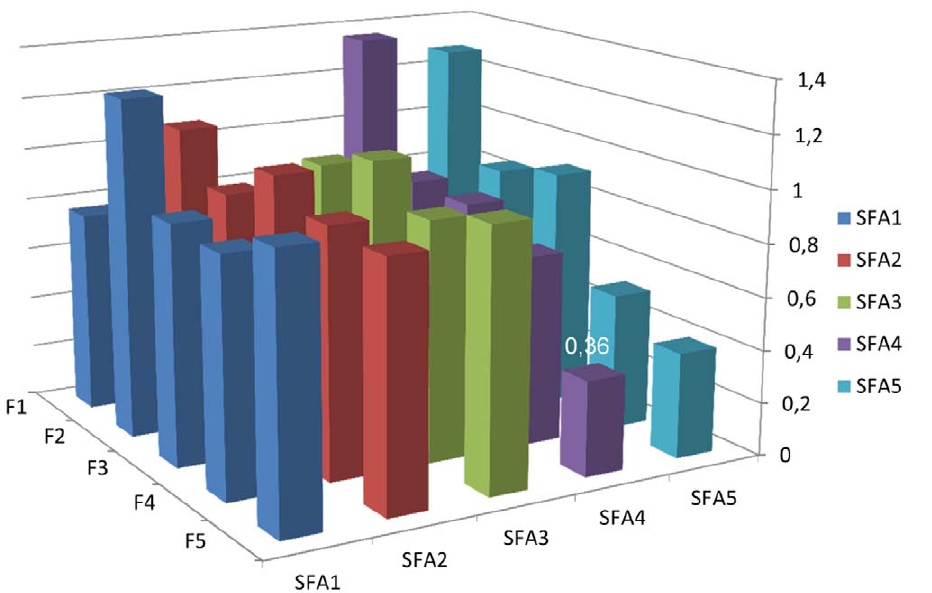
Figure 2. Joint effects of saturated fat and fiber intake on iCVD risk, women. Joint effects of quintiles of energy-adjusted saturated fat and fiber intake on risk of ischemic cardiovascular disease in women of the MDC cohort, expressed as hazard ratios. The numbers given in the figure are those significantly different ( p , 0.05) from the reference category (F5/SFA1). p value for the interaction between fiber and saturated fat=0.003. Adjusted for age, method version, total energy intake (continuous), season, BMI class, smoking category, education, alcohol category, systolic blood pressure, antihypertensive treatment, antilipemic treatment and leisure time physical activity (quartiles). RR:s calculated with no individual nutrient variables in the model due to redundancy.